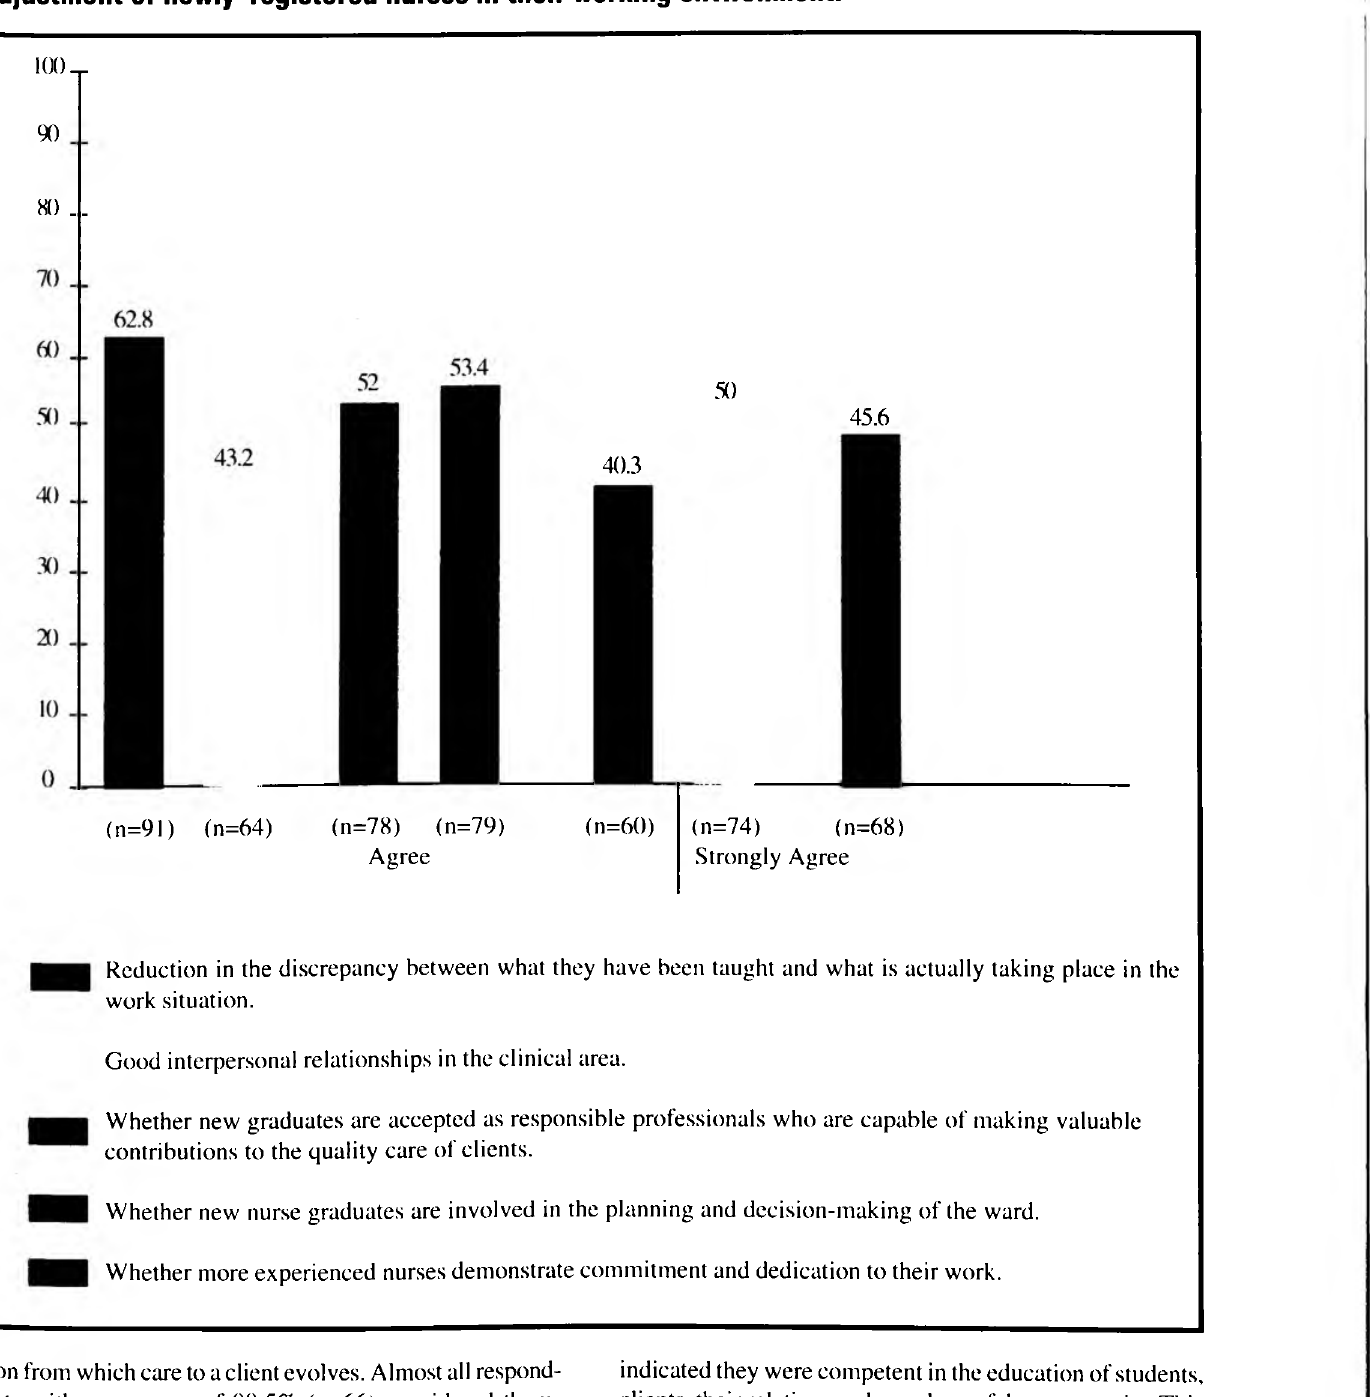
Figure 6: Professional nurses* perceptions regarding the factors that contribute to the adjustment of newly registered nurses in their working